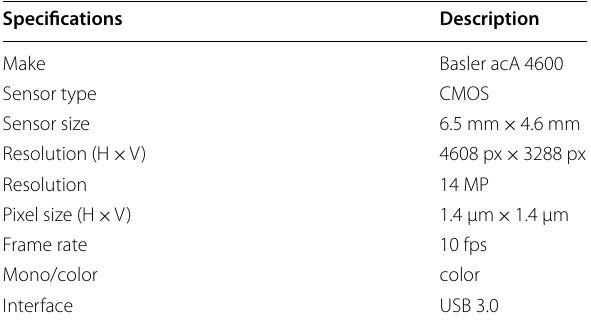
Table 1 Major specifications of camera used for leather image